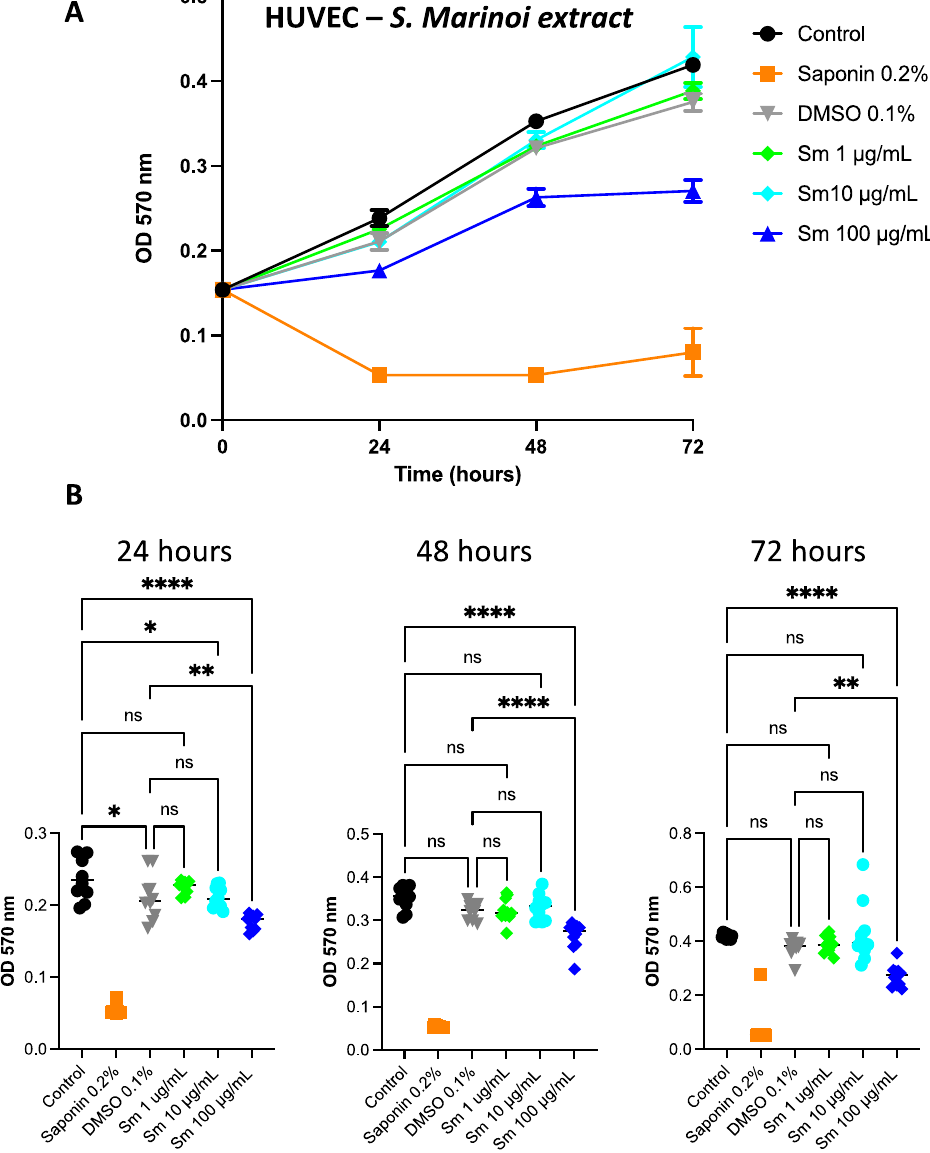
Figure 7. Effects of S. marinoi extract on HUVEC proliferation. ( A ) The proliferation rate was measured by MTT assay (OD 570 nm). ( B ) HUVECs treated with Sm at 1, 10, and 100 µg/mL for 24, 48, and 72 h and corresponding control and DMSO concentrations. Results are shown as mean ± SEM, one-way ANOVA, ns = not significant, * p < 0.05, ** p < 0.01, **** p < 0.0001 ( n = 10).